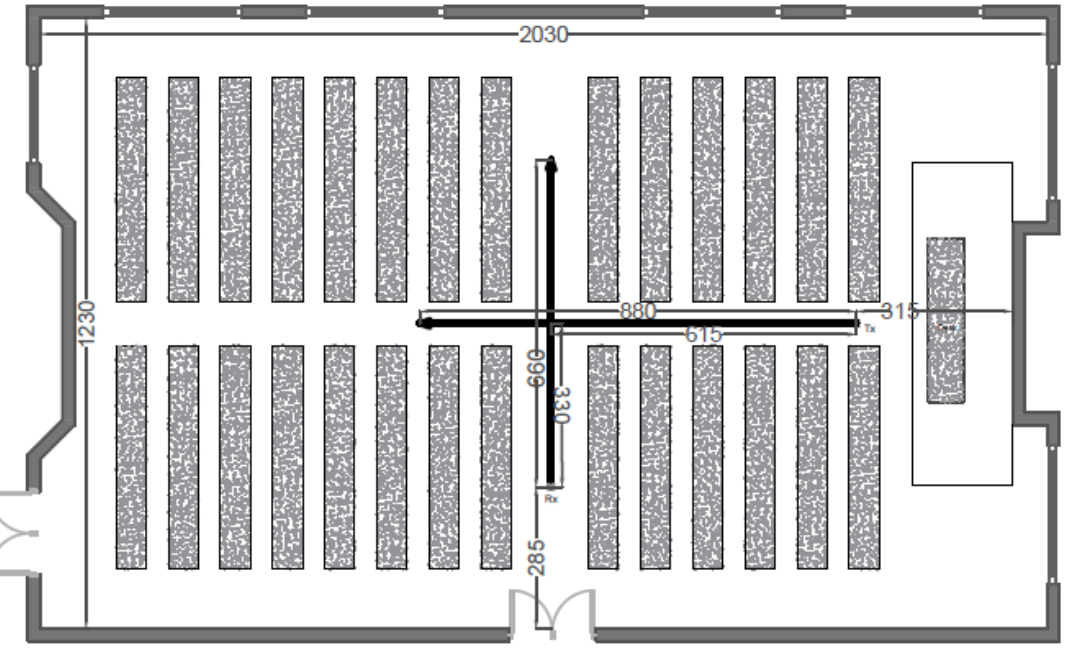
Figure 3. Floorplan of the auditorium with dimensions in cm.